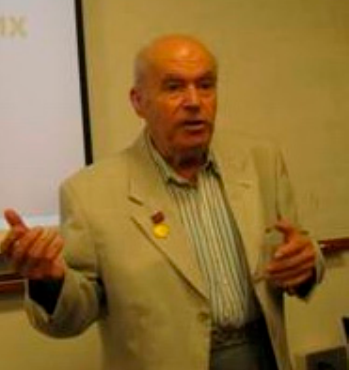
Figure 1. Prof. Naum Neishtadt, one of the founders of the piezoelectric method of geophysical prospecting (1927–2016).